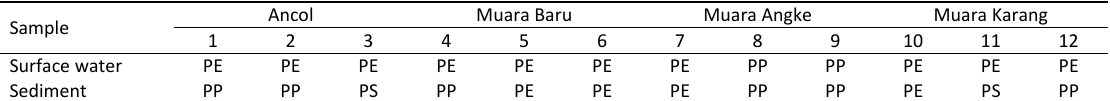
Table 4: Microplastic polimer